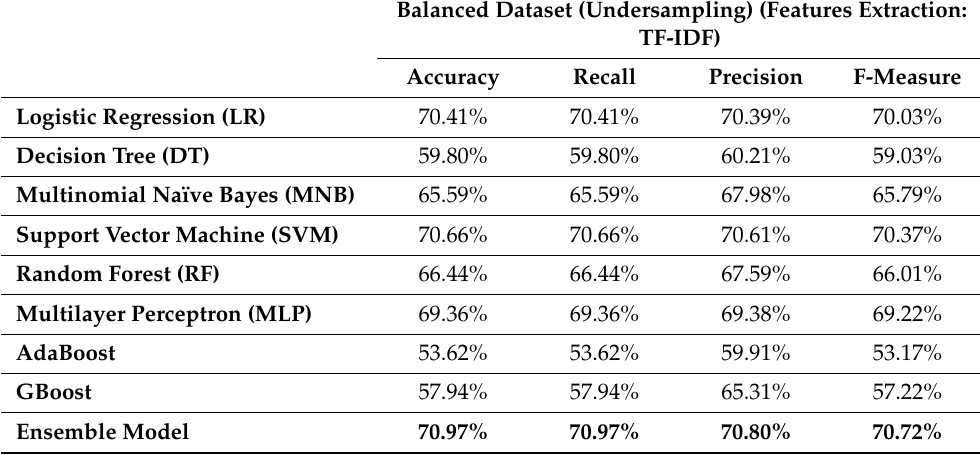
Table 7. Classification results for sentiment analysis of balanced dataset (undersampling).